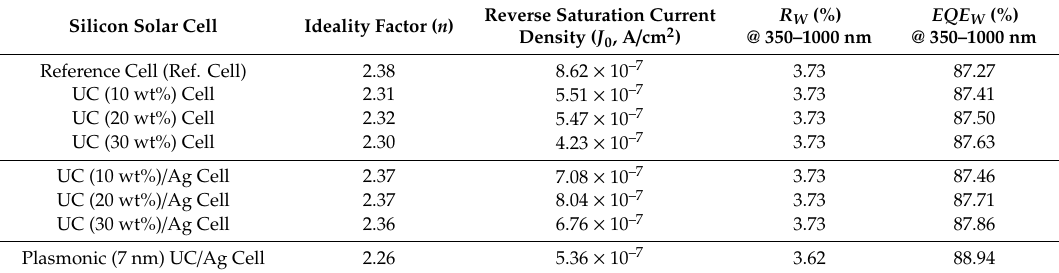
Table 1. Ideality factor (n), reverse saturation current density ( J 0 ), average weighted reflectance ( R W ), and average external quantum e ffi ciency ( EQE W ).